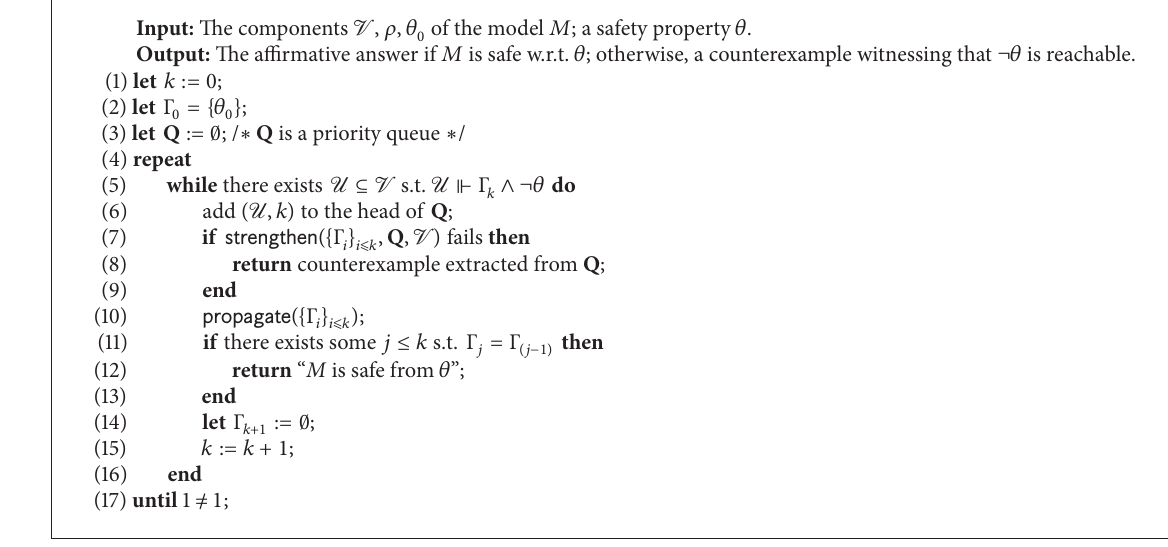
Algorithm 2: Framework of the PDR